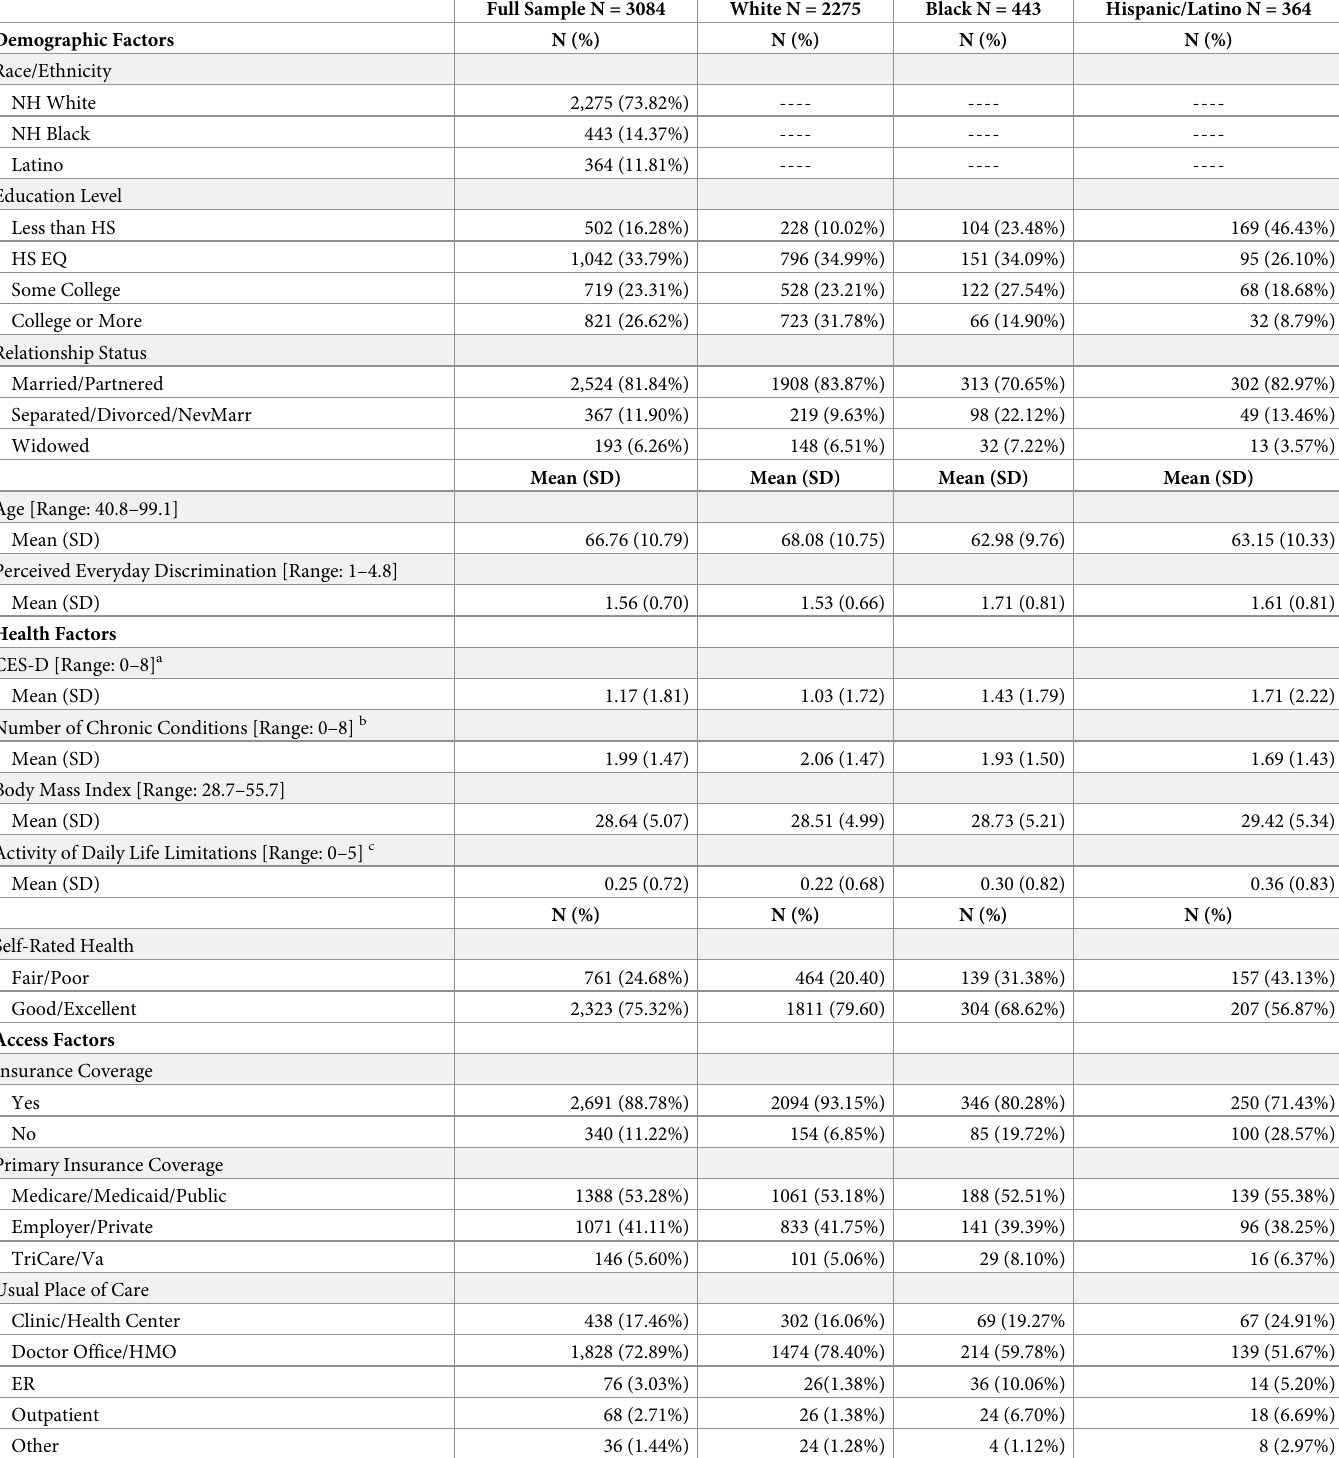
Table 1. Sample characteristics for full sample and by race/ethnicity. HRS, HCMS, PLBS